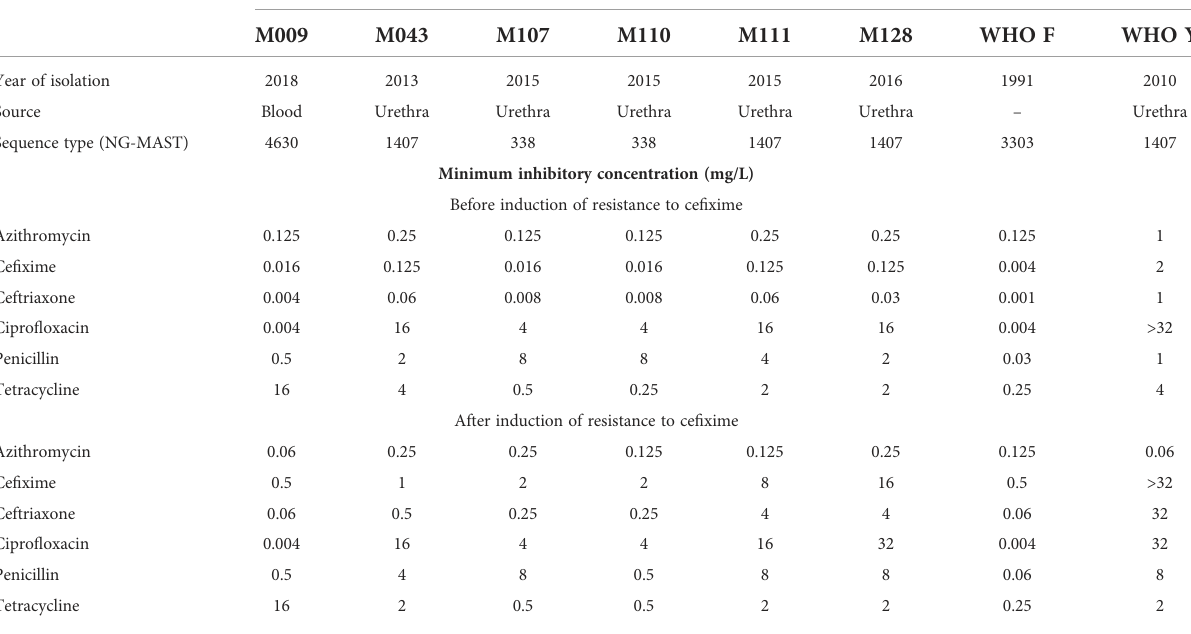
TABLE 1 Antimicrobial susceptibilities and molecular typing of Neisseria gonorrhoeae isolates included in this